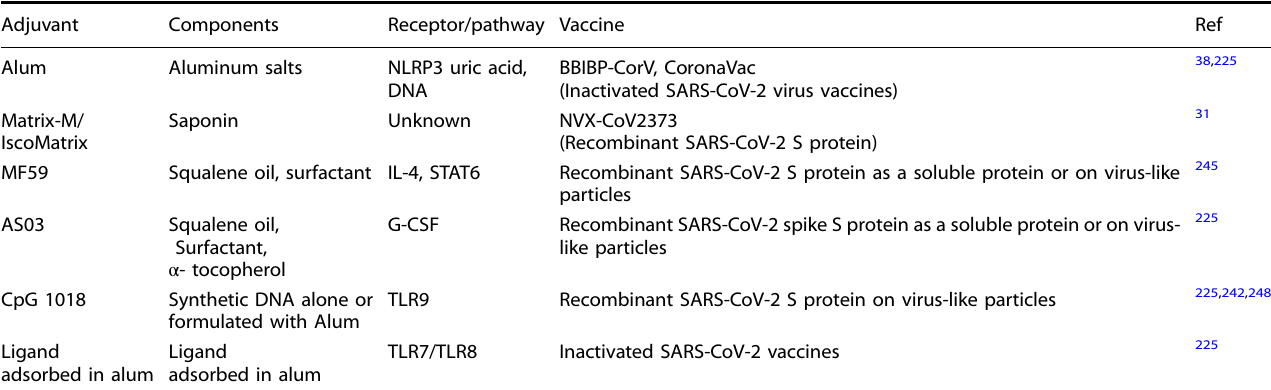
Table 4. Adjuvants used in COVID-19 vaccines in the clinic Adjuvant